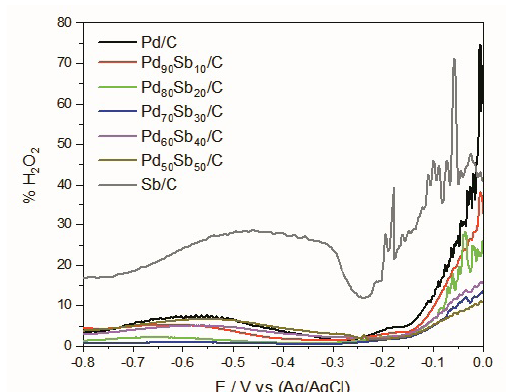
O % selectivity as a function of the applied potential. Figure 5. H 2 2